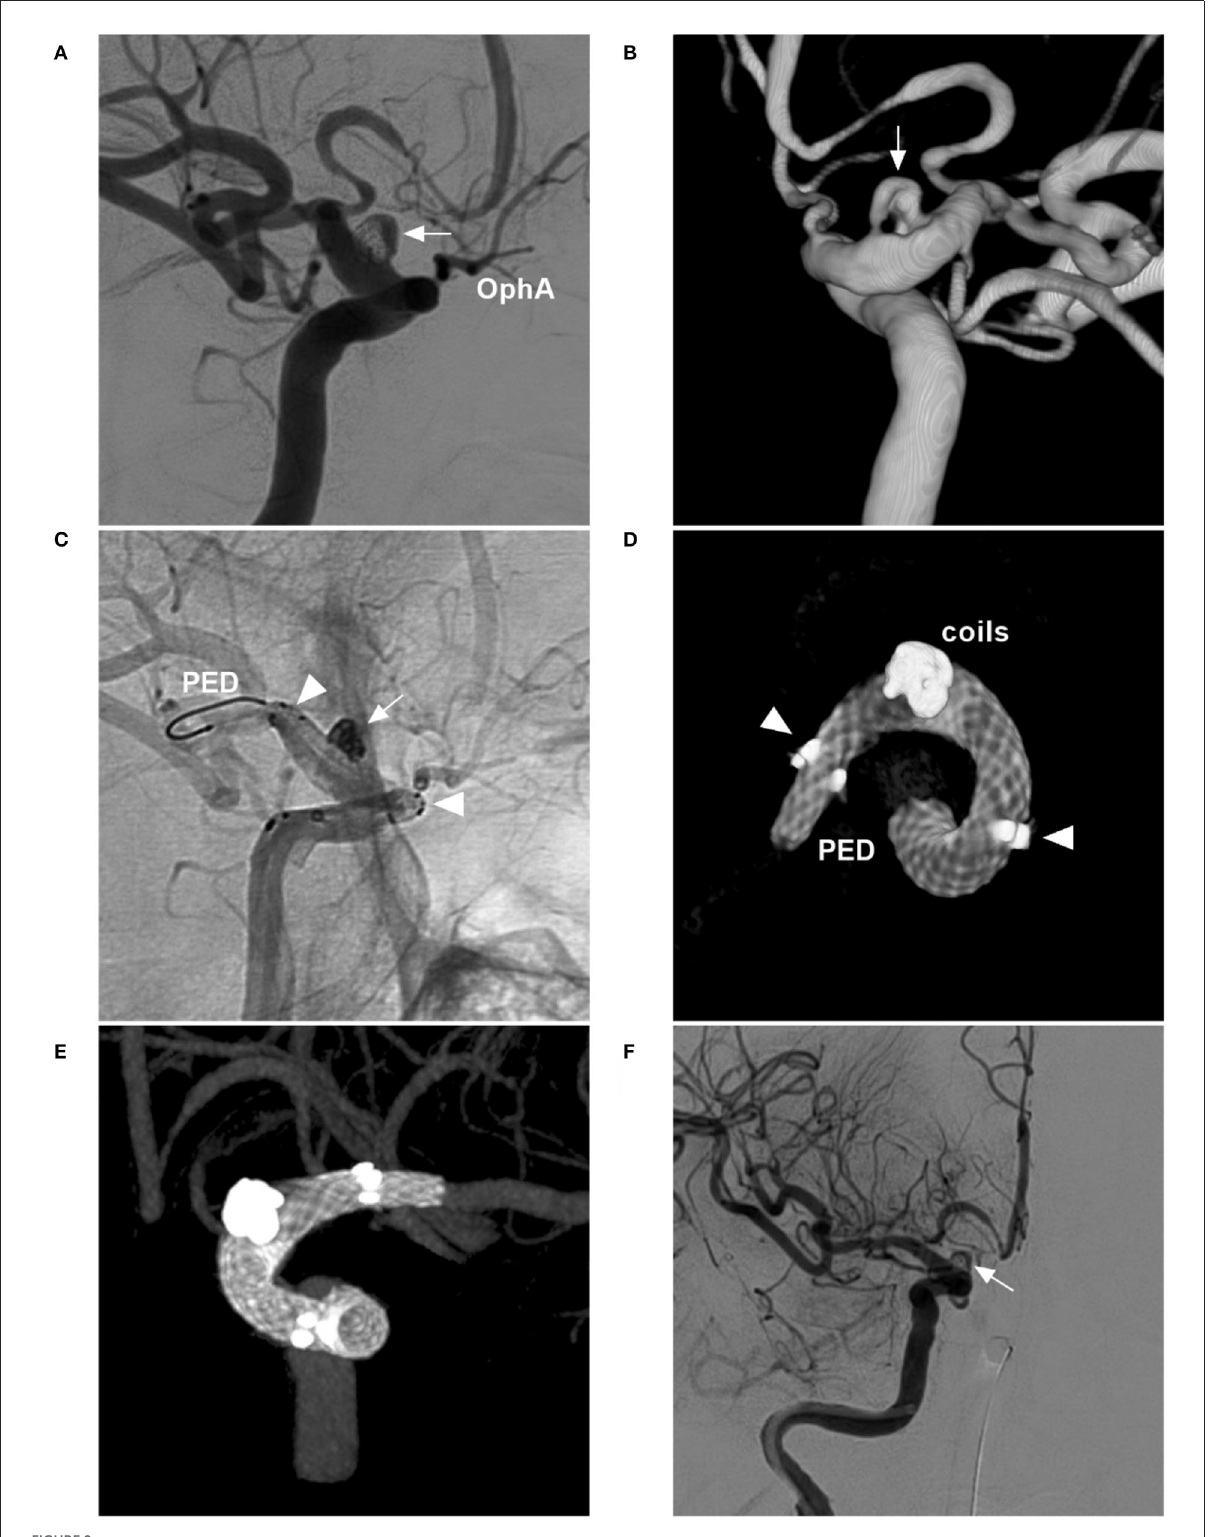
FIGURE9 FDS deployment in a BBA with failed previous stent-assisted coiling. (A,B) Two-dimensional DSA (A) and three-dimensional DSA (B) show a BBA (arrows) with incomplete embolization of stent-assisted coiling. (C) Unsubtracted DSA shows the FDS (PED) crossing the BBA (arrow) and the FDS running in the stent (arrowheads). (D,E) Vaso CT without the vessel (D) and shows the FDS opened and covering the BBA in the stent